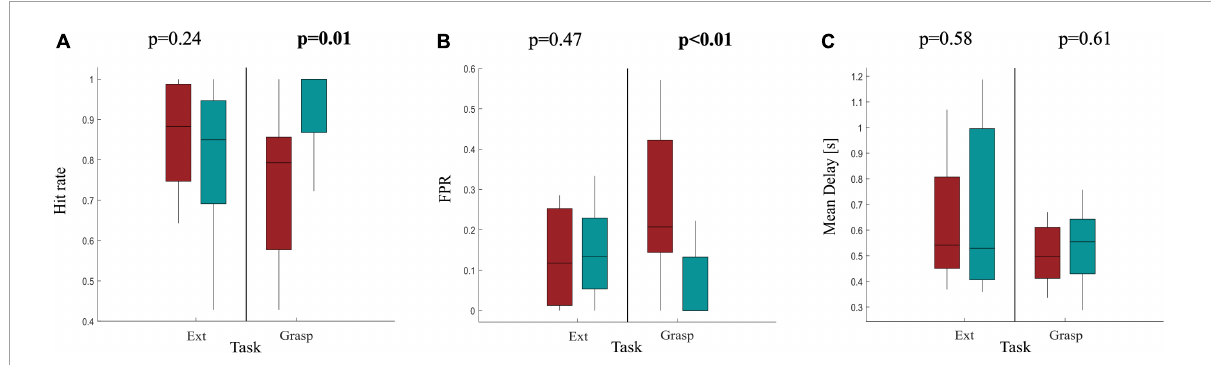
FIGURE5 Boxplot diagrams reporting the distributions of (A) the Hit rate, (B) the FPR and (C) the Mean delay in 11 stroke participants as results of the pseudo-online classification using M = 2 sliding windows as accumulation before a final classification decision. Performances are reported separately for Ext and Grasp and compared between AH and UH by means of a paired t -test ( α = 0.05), significant p -values are highlighted in bold at the top of each